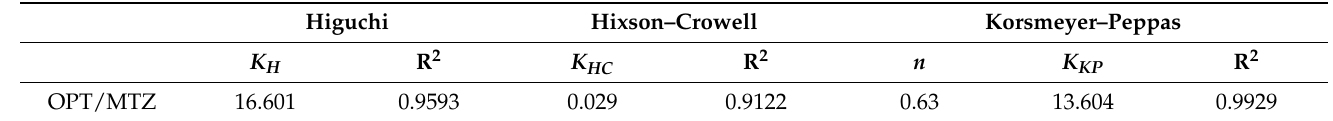
Table 3. Release parameters for hydrogel according to different mathematic models.